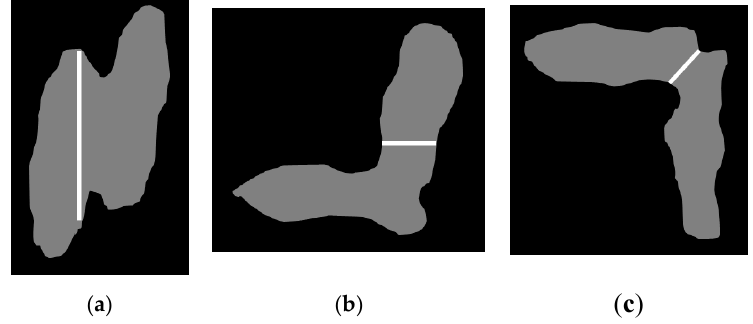
Figure 8. Segmentation with two useful BBs.